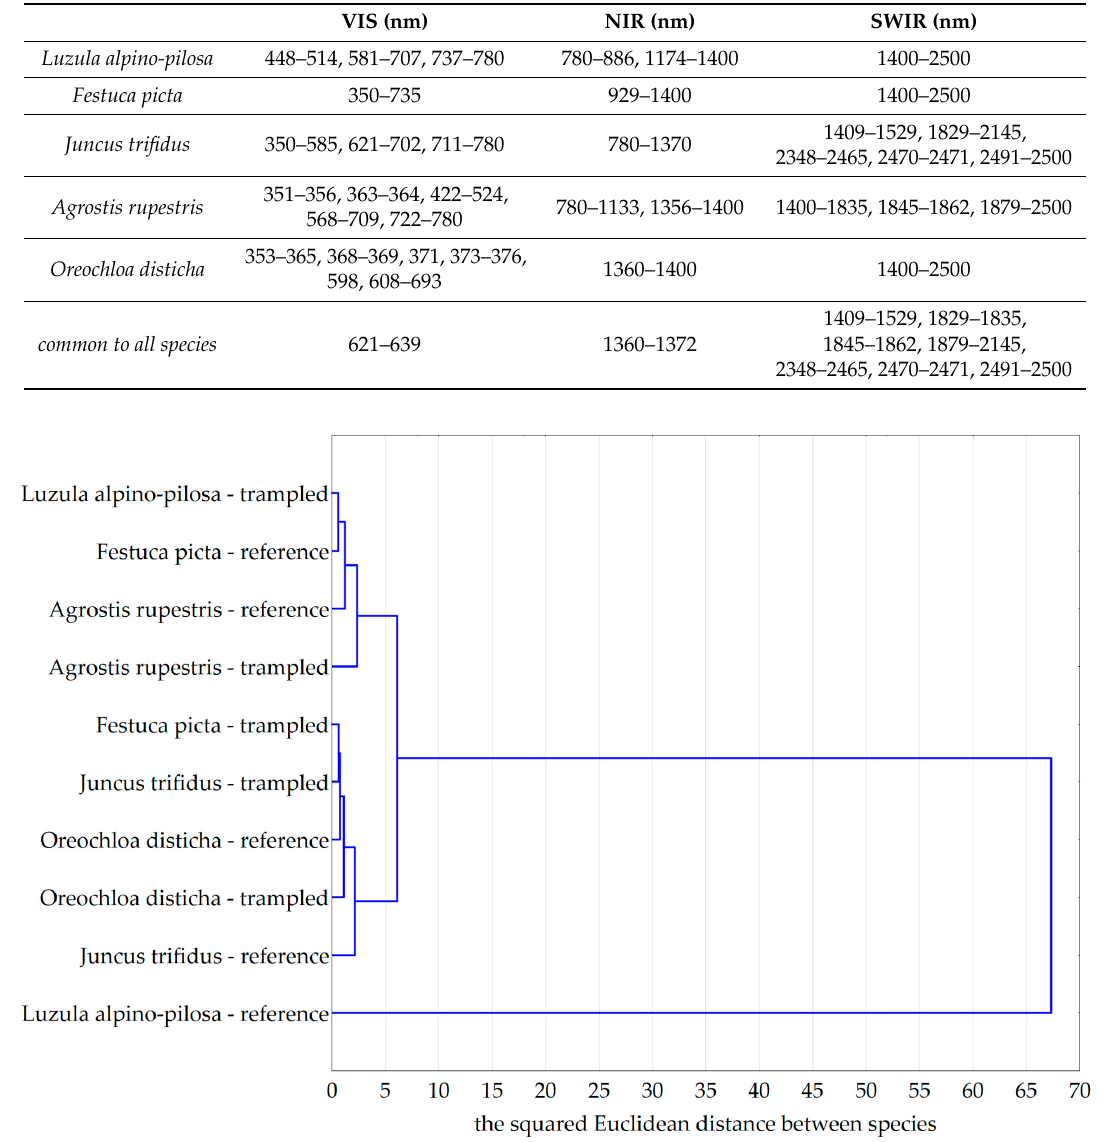
Table 2. The statistically significant different spectrum ranges of trampled and reference species at the significance level of 0.05.